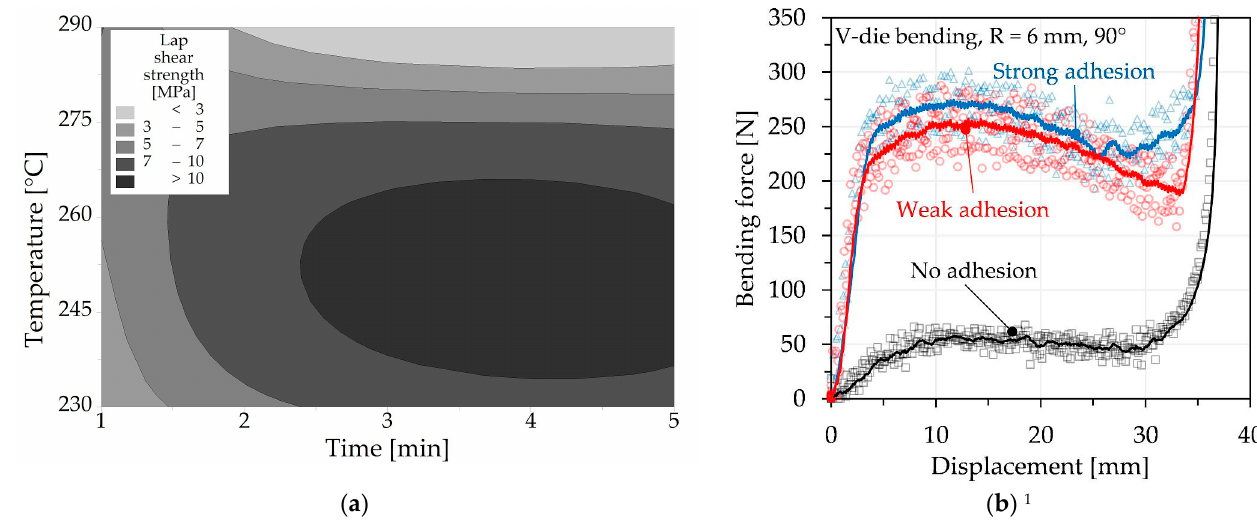
1 : the measured force–displacement data are smoothed through an average function with a 10 points step. Figure 2. ( a ) Contour chart showing a summary of the lap shear results in correlation with the processing temperature and time. ( b ) Influence of the adhesions strength on the V-die bending behavior of 100 × 20 mm 2 specimens.